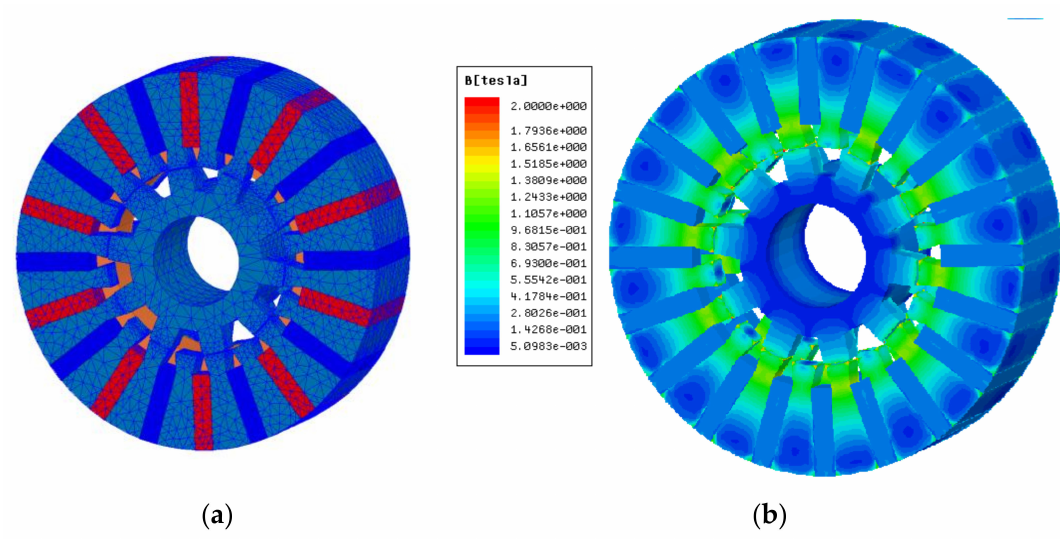
Figure 2. Mesh and no-load flux density distribution of the FSPMM. ( a ) Mesh for finite element analysis; ( b ) No-load flux density